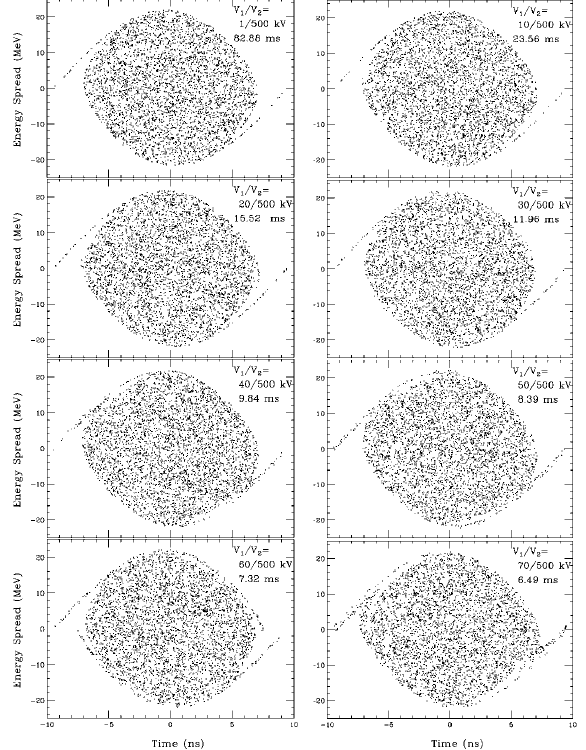
FIG. 12. Plot of a 53 MHz bunch in the longitudinal phase space after adiabatic capture starting from various initial rf voltage V 1 to the final V 2 (cid:1) 500 kV. Adiabaticity is fixed at n (cid:1) 15 and the initial bunch area is 2 3 12 3 11.134 (cid:1) 588 (cid:1) 0.4544 eV s. At V 2 (cid:1) 500 kV, the final half bunch height is 21.65 MeV and half width 7.28 ns when matched to the rf